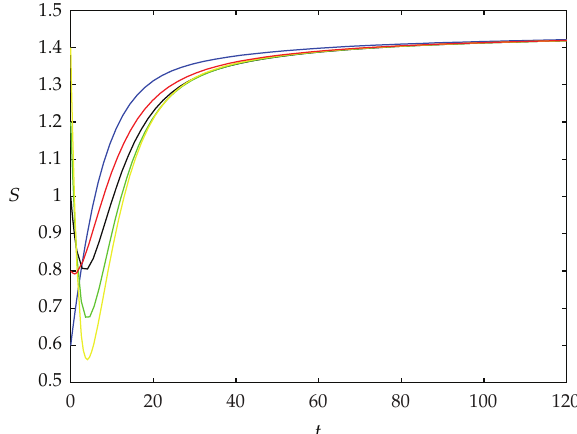
Figure 4: Time series of S (cid:3) t (cid:4) with di ff erent initial values and parameters ρ (cid:7) 0 . 3 , μ (cid:7) 0 . 2 , β (cid:7) 1 . 5 , α (cid:7) 1 , r (cid:7) 0 . 5 , d (cid:7) 0 . 2 , ω (cid:7) 0 . 1 , and τ (cid:7) 0 . 5.